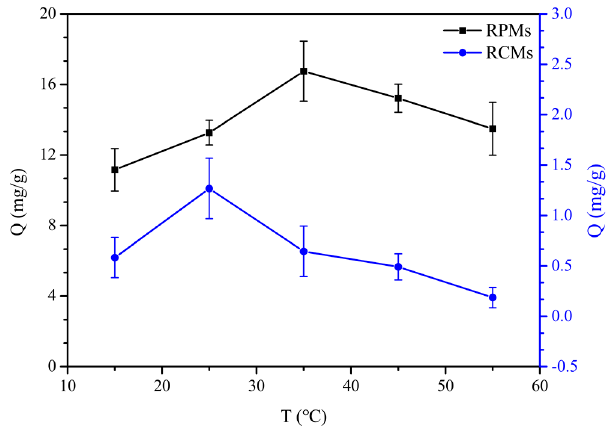
Figure 8. Adsorption thermodynamics of dencichine on RCMs and